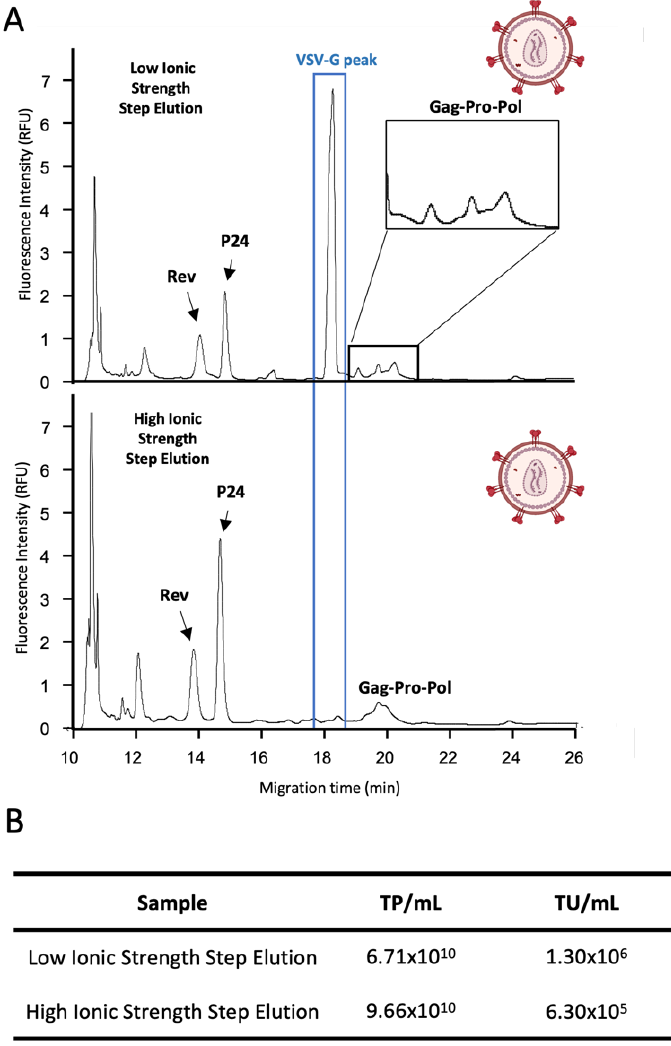
Figure 5. Evaluation of different in-process LV samples by CE. ( A ) Comparison of the two elution fractions of LV IEX chromatographic step (low and high ionic strength, upper and lower panel, respectively). ( B ) Table representation of the TP/ml and TU/ml for both in-processing elution fractions.